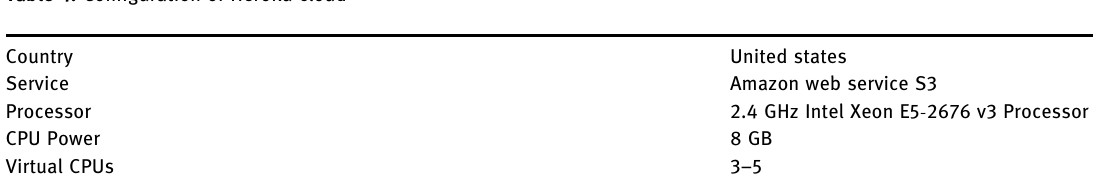
Table 4: Con fi guration of Heroku